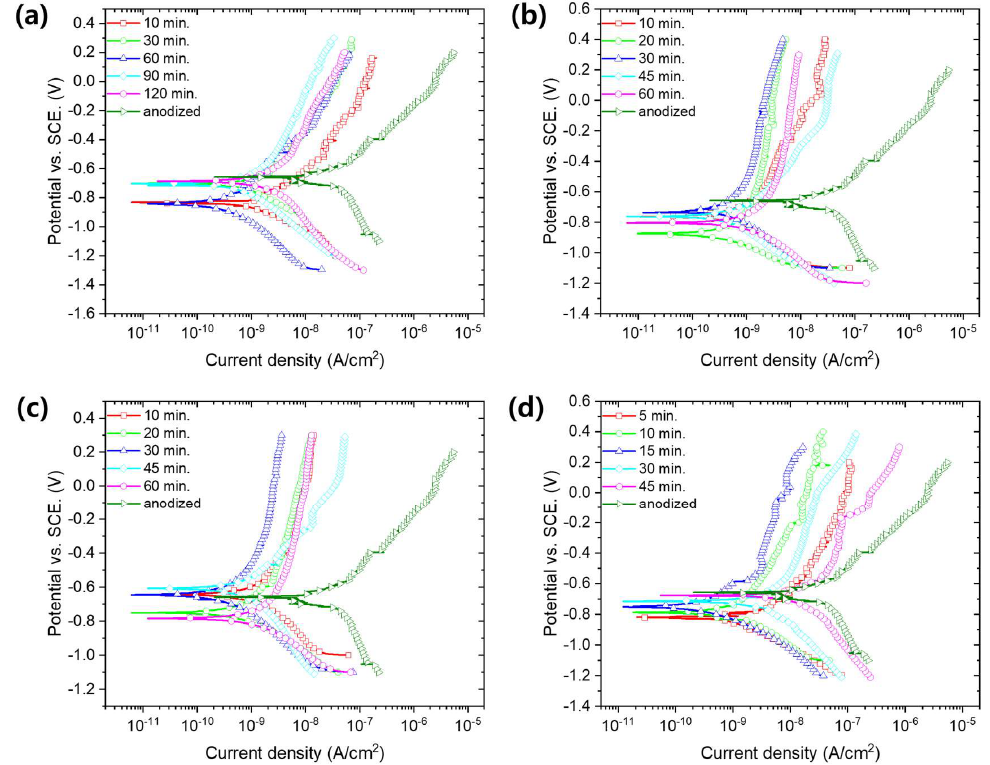
Figure 6. Potentiodynamic polarization curves of anodized aluminum alloy 6061 with sealing in mixed solution ( a ) MSS1, ( b ) MSS2, ( c ) MSS3 and ( d ) MSS4 with respect to various treatment times.